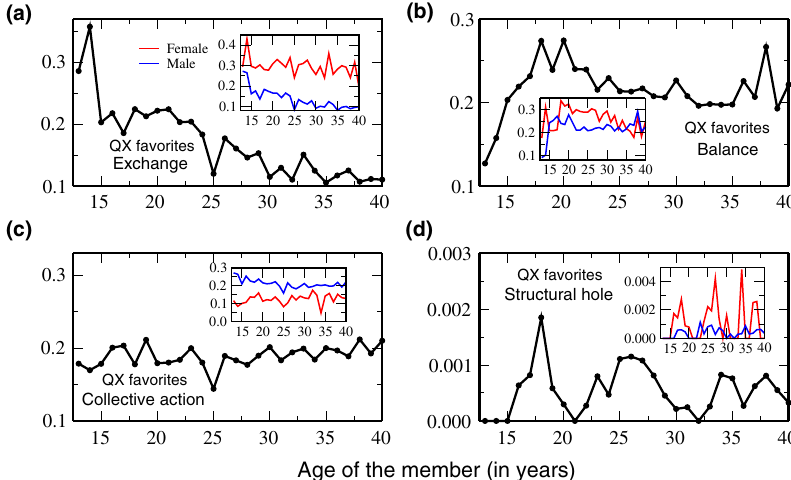
FIG. 4. Variation of the average tendency percentage with the self-reported age of the QX members. (a) The exchange tendency decreases with age. (b) The balance tendency is sharply increasing with age in younger ages, and slowly declines for ages above 20 years. We do not observe any strong dependence on age for (c) collective action or (d) structural hole (bottom right). The insets show the differences between males and females of the same age for each